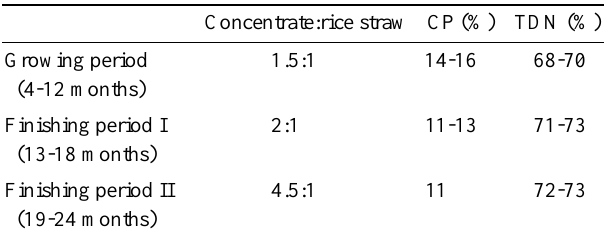
Table 1. Description for composition of intake for steers of each growth